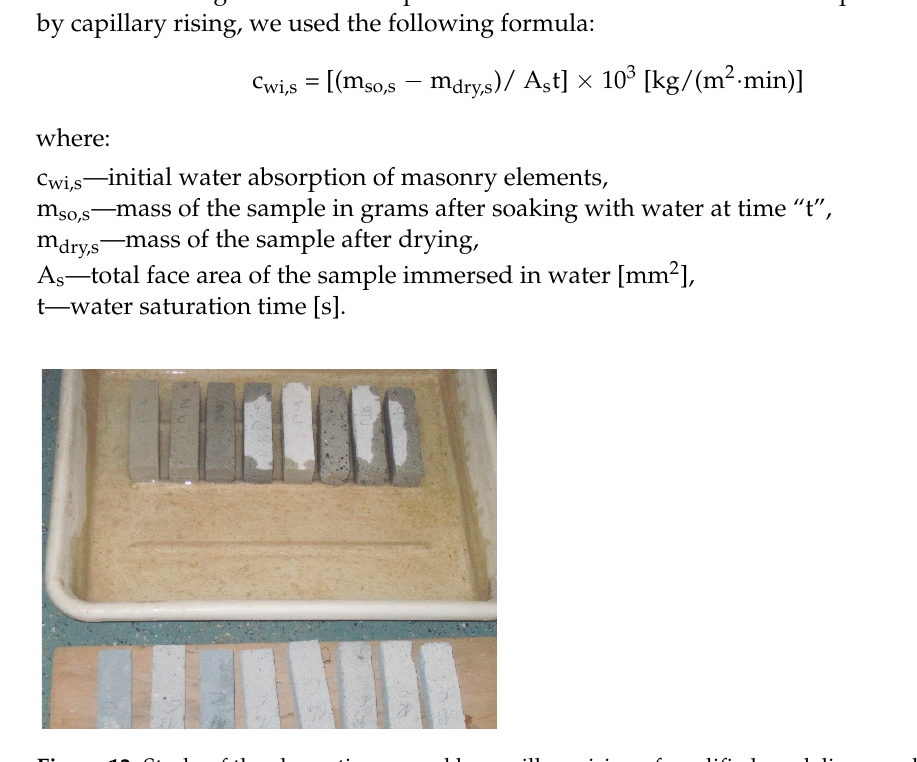
39.26 Figure 13. Dependence of compressive strength (red line), bulk density (blue line) and water absorption (green line) of silicate autoclaved materials modified with Humus Activ and Biohumus Extra Universal. As the analysis showed, changes occurred in the compressive strength and bulk den- sity, while water absorption was reduced to 9% and kept at a constant level (Figure 14). As mentioned, the modifier did not change the porous structure due to its liquid form, but due to its different density than water, it changed the physical and chemical parame- ters. Micro-CT analysis was performed on a Nikon XT H 225 ST CT scanner (Minato-ku, Japan). The industrial computed tomograph is designed for non-destructive testing, as well as non-surface and visualization analyses, which enables an insight into the interior of the tested material.